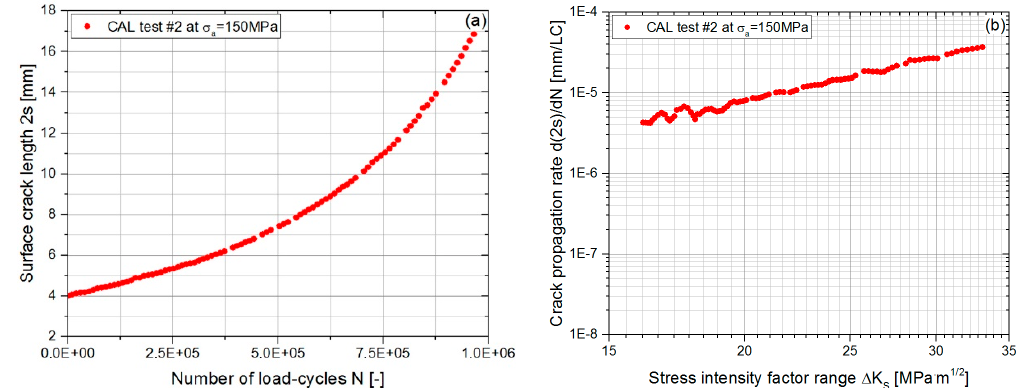
Figure 3. Results of CAL test #2 at load of σ a = 150 MPa ( a ) surface crack length vs. load-cycles; ( b ) crack propagation rate vs. stress intensity factor.